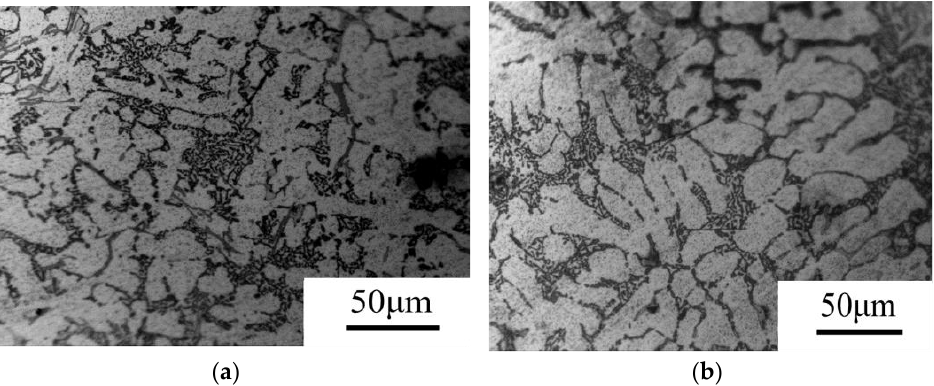
Figure 4. Microstructure of A380 alloy with different Ca additions at 50 °C/s cooling: ( a ) 0.05 wt.%; ( b ) 0.1 wt.%.